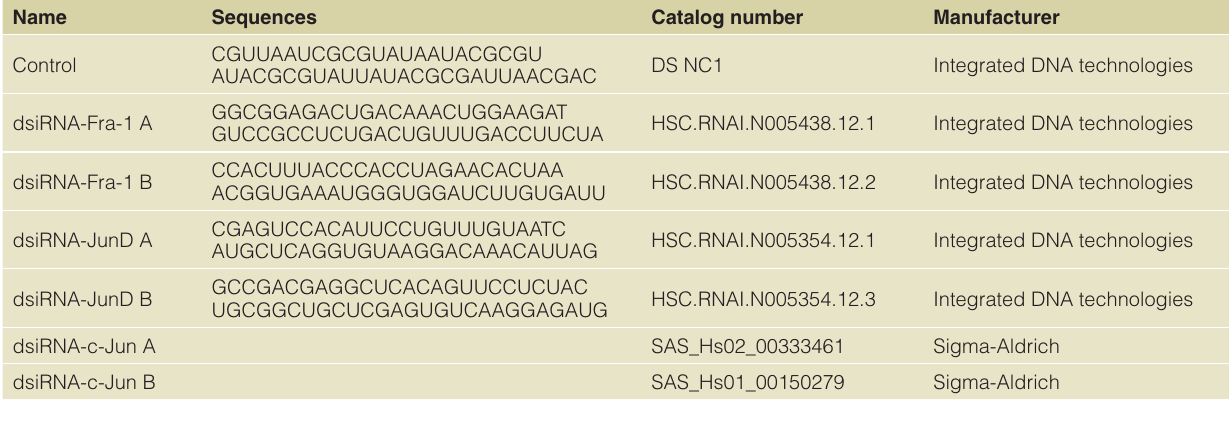
Table 3. siRNA oligonucleotide sequences. The two oligonucleotides shown for each gene were annealed for use as siRNA. The Manufacture and catalog number for each are indicated. Name